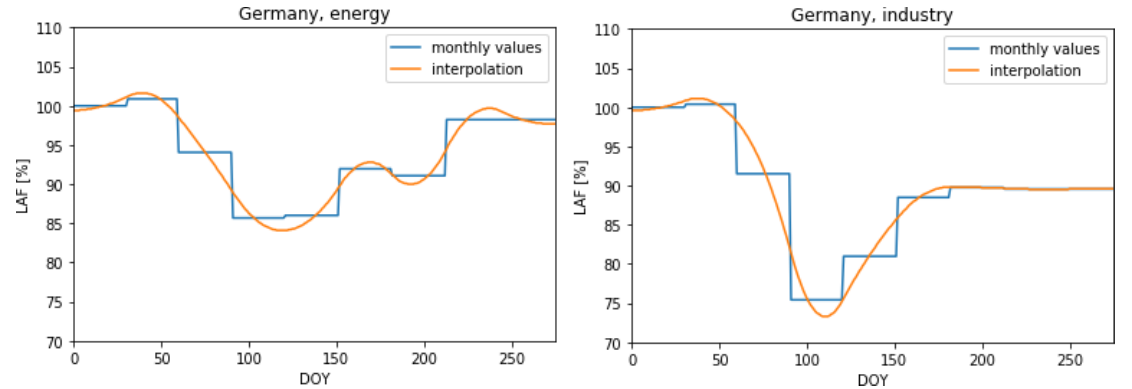
Figure 2. Examples for monthly values and interpolated functions for lockdown adjustment factors (in %) for the sectors A_PublicPower and B_Industry in Germany.